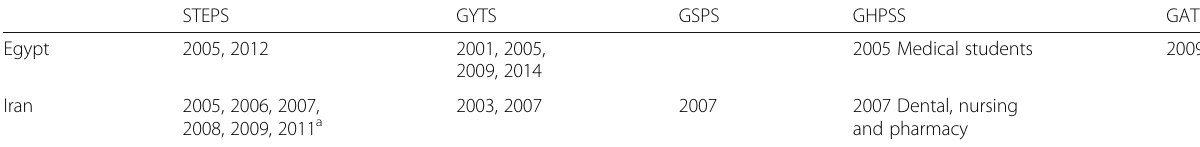
Table 2 Dates and names of risk factor national surveillance surveys were carried out which collected information on tobacco